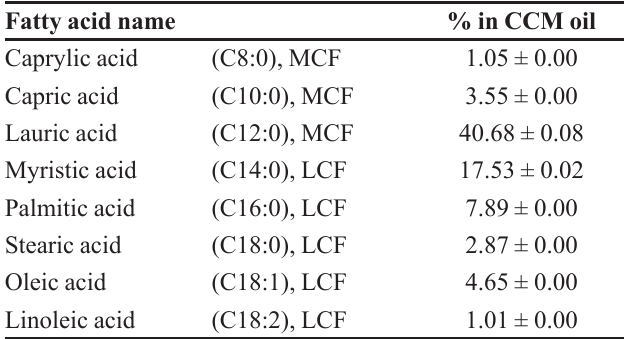
TABLE I - Fatty acids composition (in percent) of CCM oils